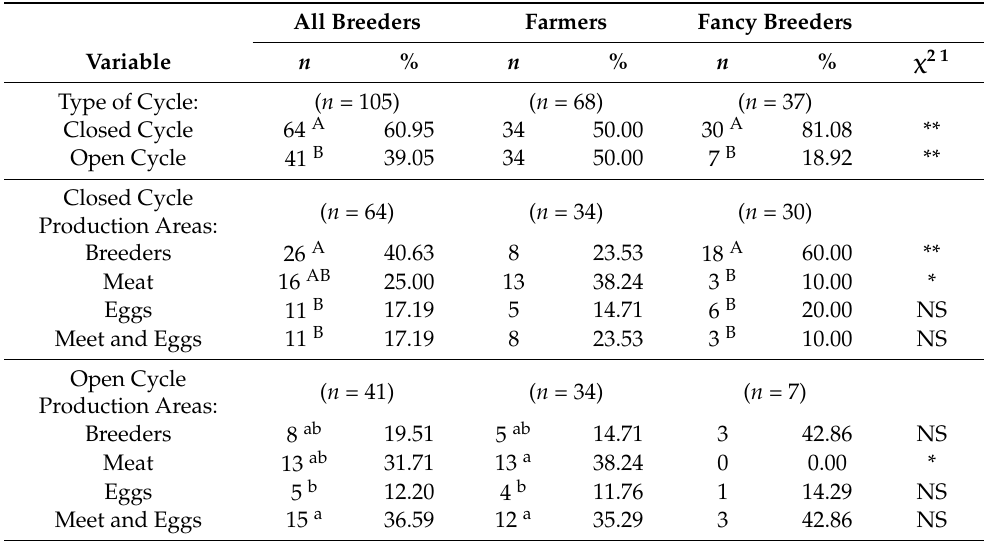
Table 1. Type of production cycle and related production areas: responses from all breeders and divided according to breeder category. All Breeders Farmers Fancy Breeders